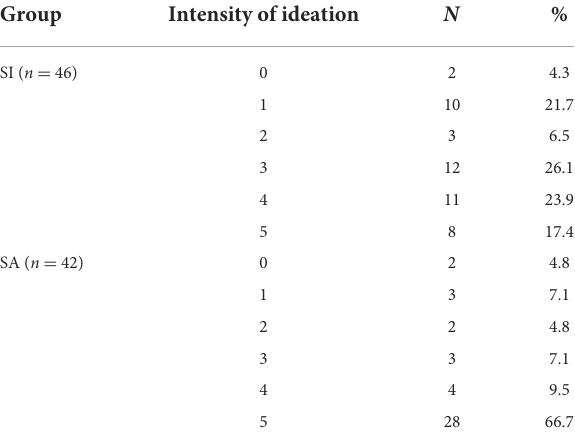
TABLE 2 Distribution of the C-SSRS intensity of suicidal ideation in the SA and SI groups.